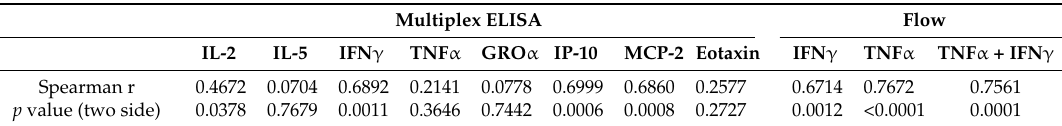
Figure 2. Flow cytometry results, gating strategy and analysis of whole blood from survivors and non-infected controls following SUDV whole antigen stimulation. ( A ) Plots depict IFN γ and TNF α cytokine responses in CD4 T cells following 22 h of stimulation with inactivated SUDV antigen, in non-infected controls, SUDV survivors without antibodies response, SUDV survivors with antibodies response and neutralization capability. Values in parentheses indicate the respective values for resting cultures that did not receive antigen; ( B ) Gating strategy for plots shown in ( A ); ( C ) Grouped column scatter plot showing the frequency of IFN γ single positive (SP), TNF α SP, or double positive (DP) events among CD4 T cells. Survivors are grouped according to the presence of IgG antibodies to SUDV antigen or GP 1-649 and ability to neutralize live SUDV (Table 1). S: SUDV survivor; C: non-infected control; SP: single positive; DP: double positive; *: p < 0.05 SUDV Neut+ vs. SUDV Ab+ no Neut; #: p < 0.05 SUDV Neut+ vs. no SUDV Ab. Table 2. Correlation analysis between neutralization (1:80 dilution) and cytokine and chemokine secretion levels by multiplex ELISA and Flow cytometry following SUDV whole antigen stimulation in SUDV survivors and non-infected controls. Multiplex ELISA Flow